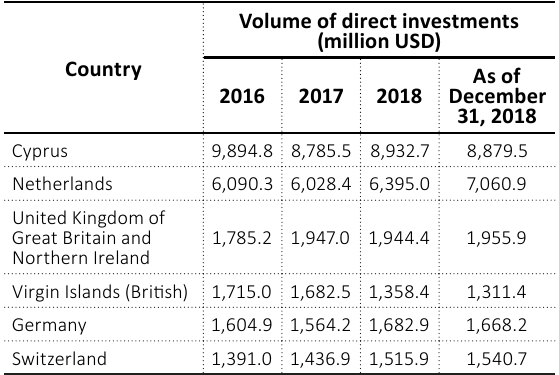
Table 2. Direct investments (share capital) from the countries of the world into the Ukrainian economy